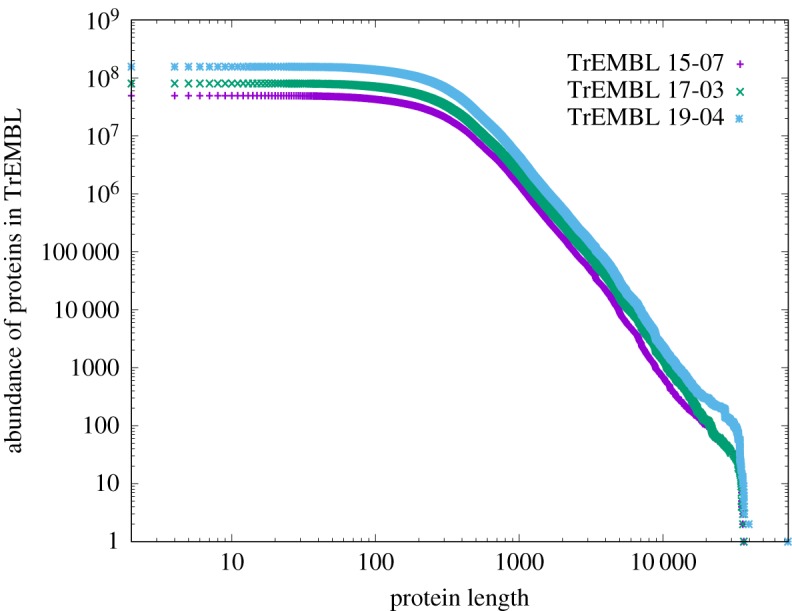
The cumulative ccdfs of three releases of the TrEMBL protein database spread across some four years, 15-07, 17-03 and 19-04. In this period, the database grew by a factor of four. The self-similarity is obvious just as it is in software systems [12].